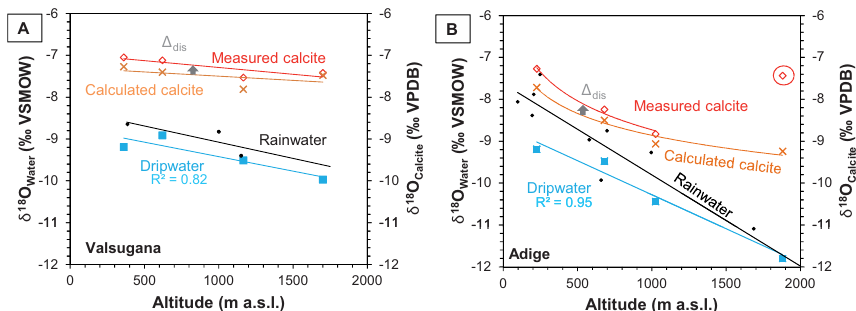
Fig. 8. Oxygen isotope values of the (A) Valsugana and (B) Adige Valleys plotted against altitude. Annual weighted-average rainwater values are shown in black dots (Bert`o et al., 2005), cave dripwaters (solid blue squares) and corresponding calculated (Kim and O’Neil, 1997; updated by Kim et al., 2007) and measured calcite precipitates (orange crosses and red open diamonds, respectively). The calcite points plotted represent only one sample from each cave that we consider to be the least modified (see Fig. 5). This plot, therefore, serves to explain the relatively un-kinetically modified processes occurring in the cave and not to show an exhaustive range of possible δ 18 O values. The DL cave calculated calcite has been computed based on long-term monitoring of the cave dripwater, rather than a one-off sample, using the δ 18 O value of − 8.31 ± 0.23‰. One outlier has been identified in the measured calcite data of (B) , that of the CB cave (1880m). Note that waters are plotted on the VSMOW scale and calcite plotted against VPDB, and therefore values are not directly